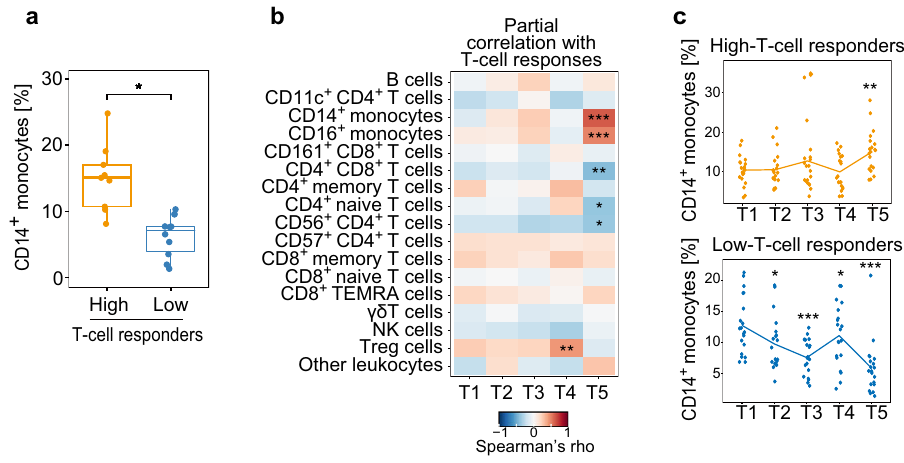
Fig. 2 Late monocyte responses are associated with BNT162b2-induced adaptive immunity. Frequency of immune cell populations in PBMCs was analyzed by CyTOF. a Frequency of CD14 + monocytes in high- and low-T-cell responders ( n = 9 and 10, respectively) in the validation group. p values were calculated with Wilcoxon signed rank tests with Benjamini – Hochberg FDR correction (* P < 0.05). Boxes show median and 25th – 75th percentiles, and whiskers show the range. b Heat map showing the correlation between the frequency of immune cell populations and vaccine-induced T-cell responses in the entire cohort ( n = 86). TEMRA, terminally differentiated effector memory; NK, natural killer. Partial correlation analyses with adjustments for age and sex were performed with Spearman ’ s correlation tests with Benjamini – Hochberg FDR correction (* P < 0.05, ** P < 0.01, *** P < 0.001). c Kinetics of the frequency of CD14 + monocytes in PBMCs during vaccine response. High-T-cell responders (upper panel, n = 20) and low-T-cell responders (lower panel, n = 20) in the entire cohort were analyzed. P values were calculated with the Wilcoxon signed rank tests with Benjamini – Hochberg FDR correction (* P < 0.05, ** P < 0.01, *** P <